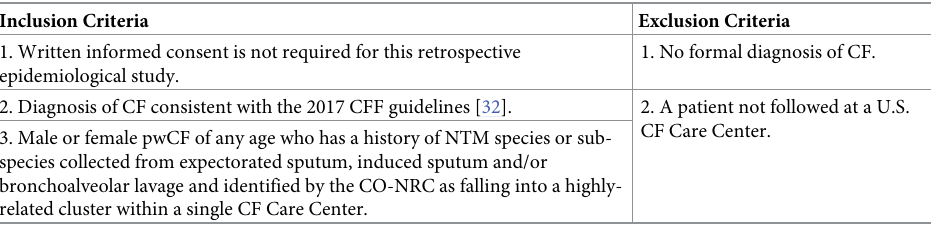
Table 2. Inclusion and exclusion